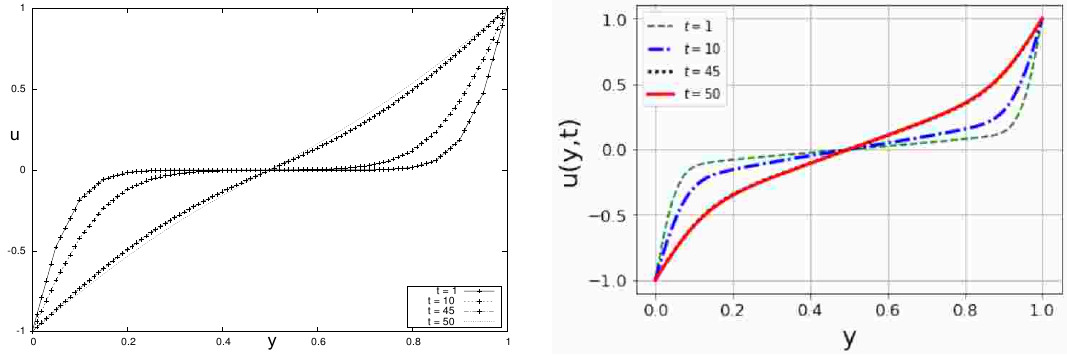
Figure 8. Velocity profile u for the anti-symmetric case (compared with reference [39] (RHS)).